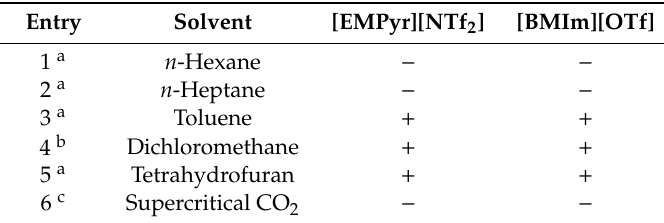
Table 3. Extractant